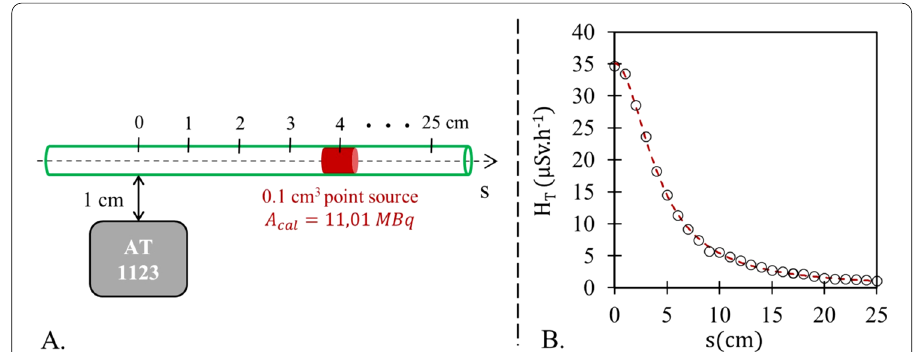
Fig. 4 A Illustration of the calibration procedure of the AT1123 survey meter according to the position of an 11.01 MBq point source along the axis of the tubing(s) and for a fixed tubing-survey meter distance of 1 cm. B Result of the calibration that provides the relationship between EDR measurements and positions of the point source (circular symbols) with the corresponding regression (dashed line)